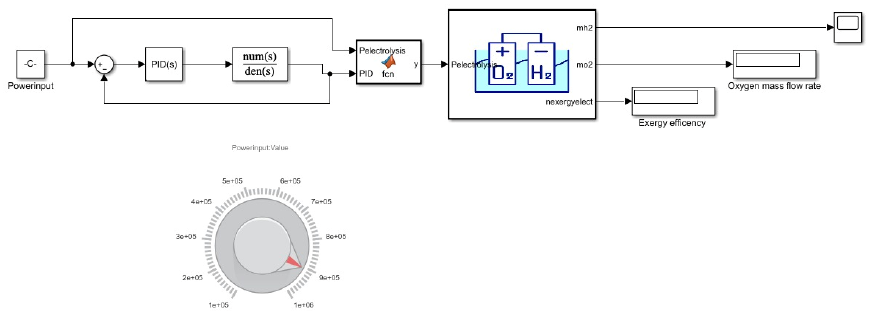
Figure 5. Electrolysis Simulink model.